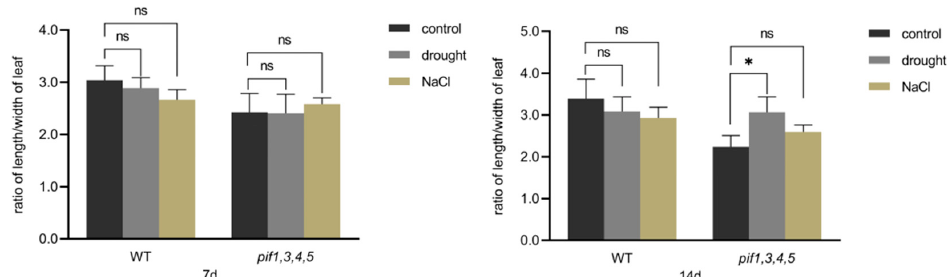
Figure 4. The changes in shape of leaves in response to NaCl and drought stresses. ( A ) The seedlings of pif1/pif3/pif4/pif5 quadruple mutant ( pif1/3/4/5 ) and WT were grown in soil for treatment with NaCl and drought for 7 days and 14 days, respectively; then the growth phenotype was recorded by photos; untreated seedlings were used as controls. Scale bar: 1 cm. ( B ) Statistical analysis of the leaf area, petiole length, and ratio of length/width of the leaf of WT and pif1/3/4/5 quadruple mutant seedlings. The data were analyzed by one-way ANOVA following Brown–Forsythe test. ns: p > 0.05; *: p < 0.05; **: p < 0.01; ***: p < 0.001. ( C ) The diagrams demonstrate the changes in leaves of pif1/3/4/5 and WT under control, NaCl, and drought conditions. Red arrows show the shrink direction of leaves of WT under NaCl and drought conditions. Scale bar: red bar 1 mm, yellow bar 50 µ